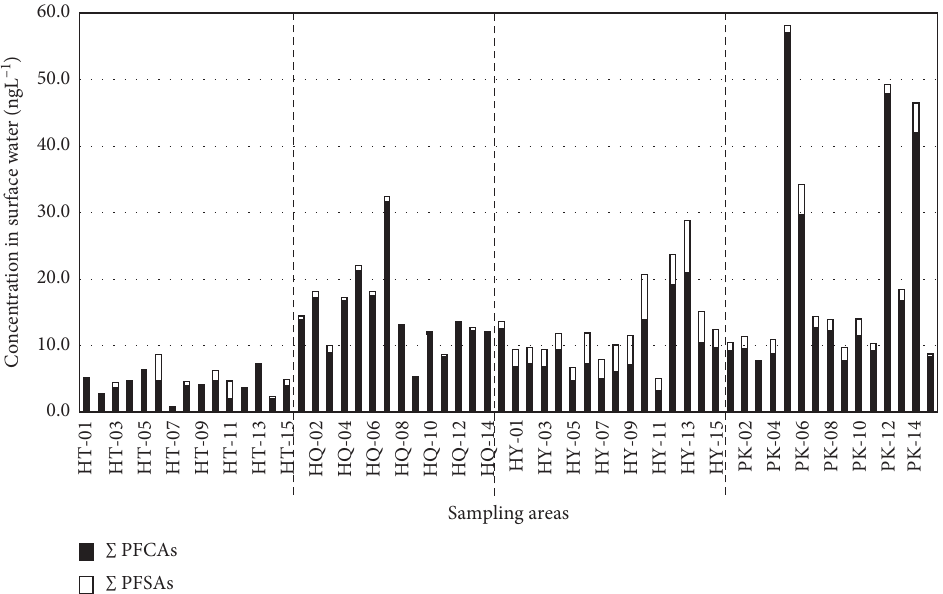
Figure 1: Total concentrations of PFCAs and PFSAs in water samples taken from craft